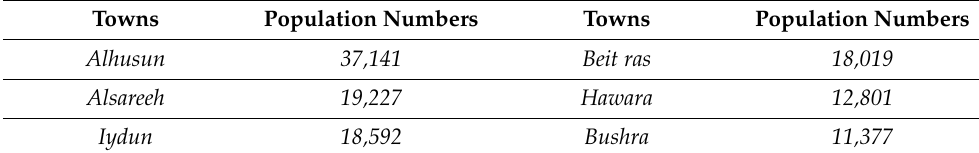
Table 1. Towns for which urban centers have been adopted in the suitability analysis [41].